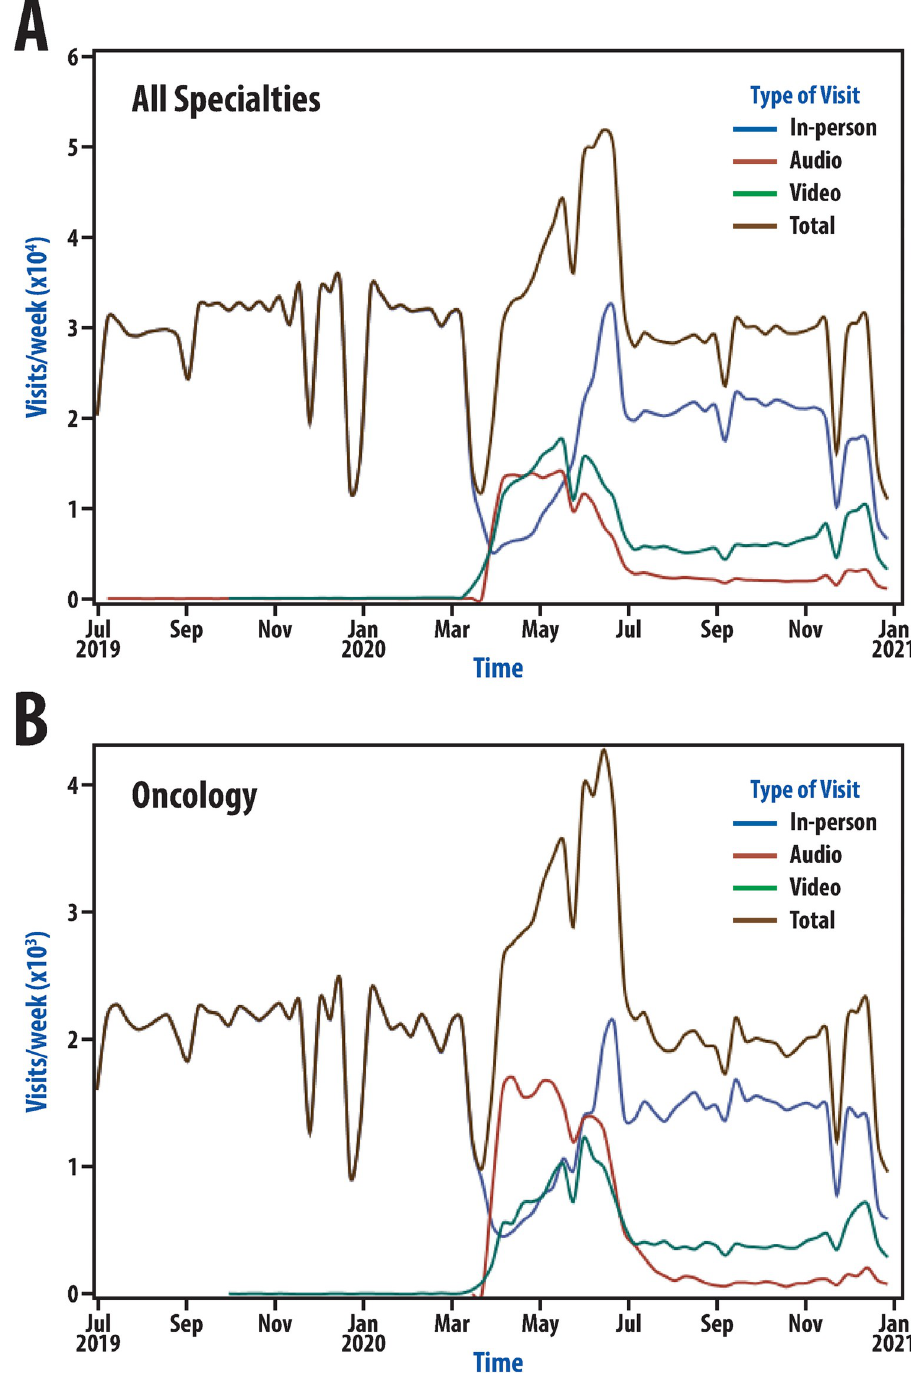
Fig 1. Pandemic visit dynamics at a large academic medical center. Number of visits by week from July 1, 2019 through December 31, 2020 for all specialties (A) and the subset of those visits that were held with oncology providers (B) during the COVID-19